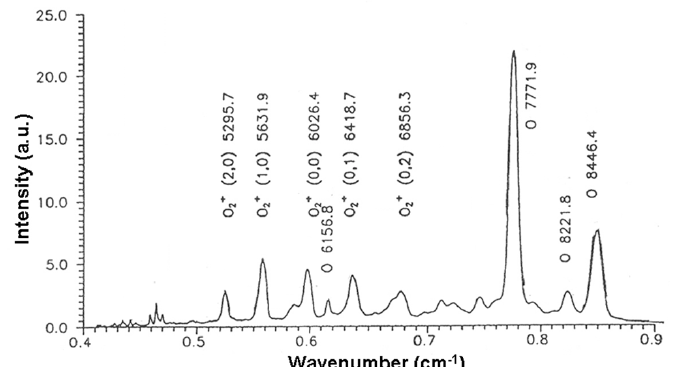
Figure 5. The optical spectrum of oxygen EBP in visible and NIR ranges; the peaks attributed to the different oxygen species are in accordance with [21,22].